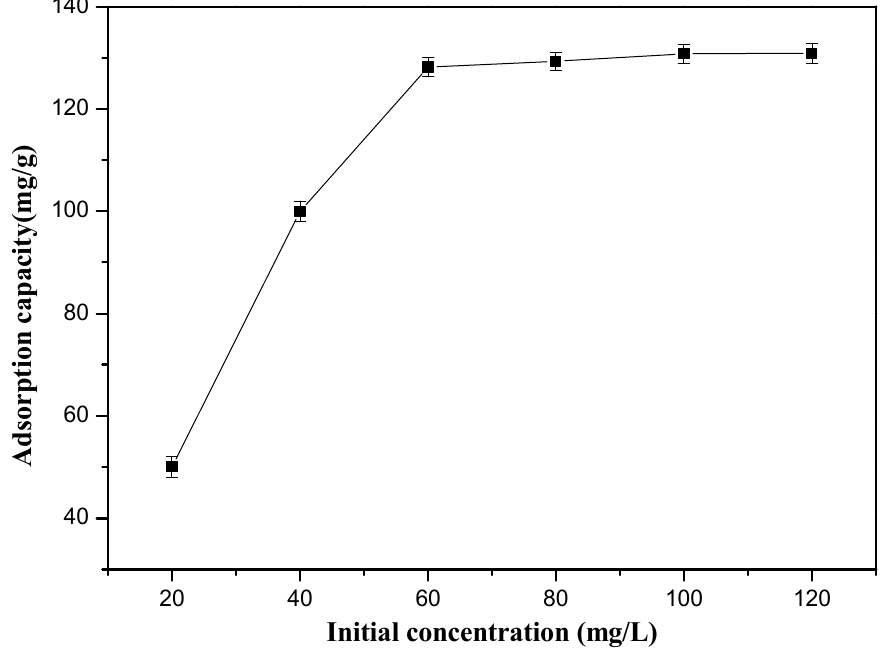
Figure 5. Effect of initial Cr(VI) ions concentration in solution on the sorption.